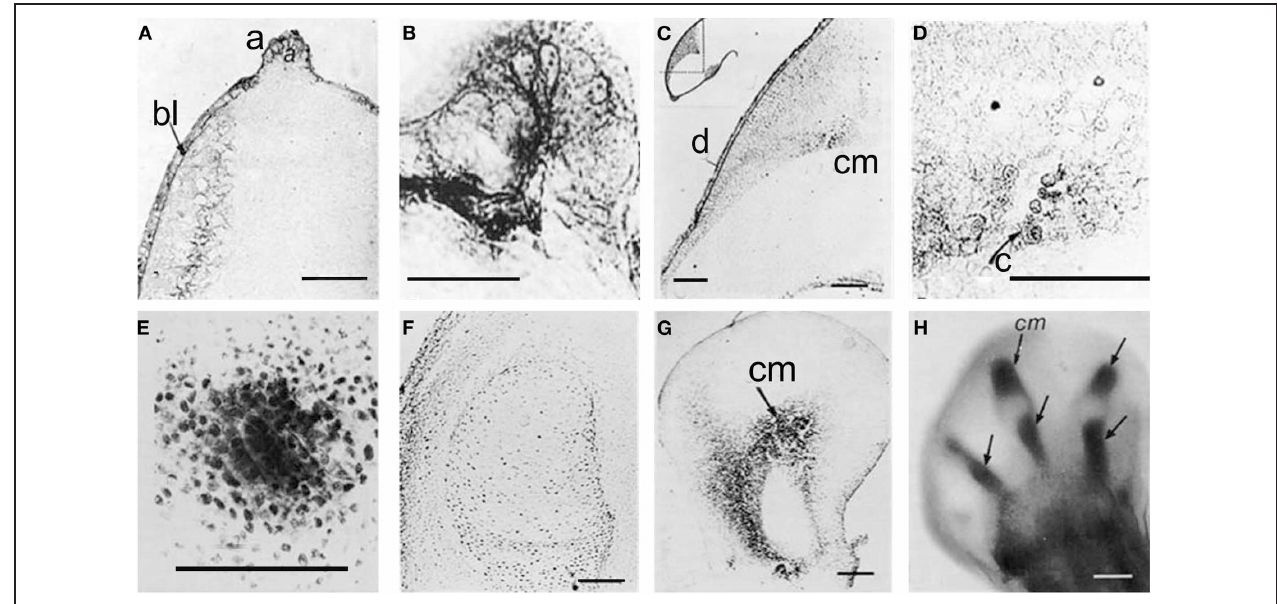
FIGURE 1 | Karnovsky and Roots 81964 reaction, showing AChE activity by a dark precipitation. (A) Forty-eight hours stage, longitudinal section, 15 μ m thick; (B) AER, same stage; (C) Seventy-two hours stage, showing that from the AER and dorsal ectoderm AChE activity is diffused to focal point where the pre-cartilage cells begin to differentiate (D) ;